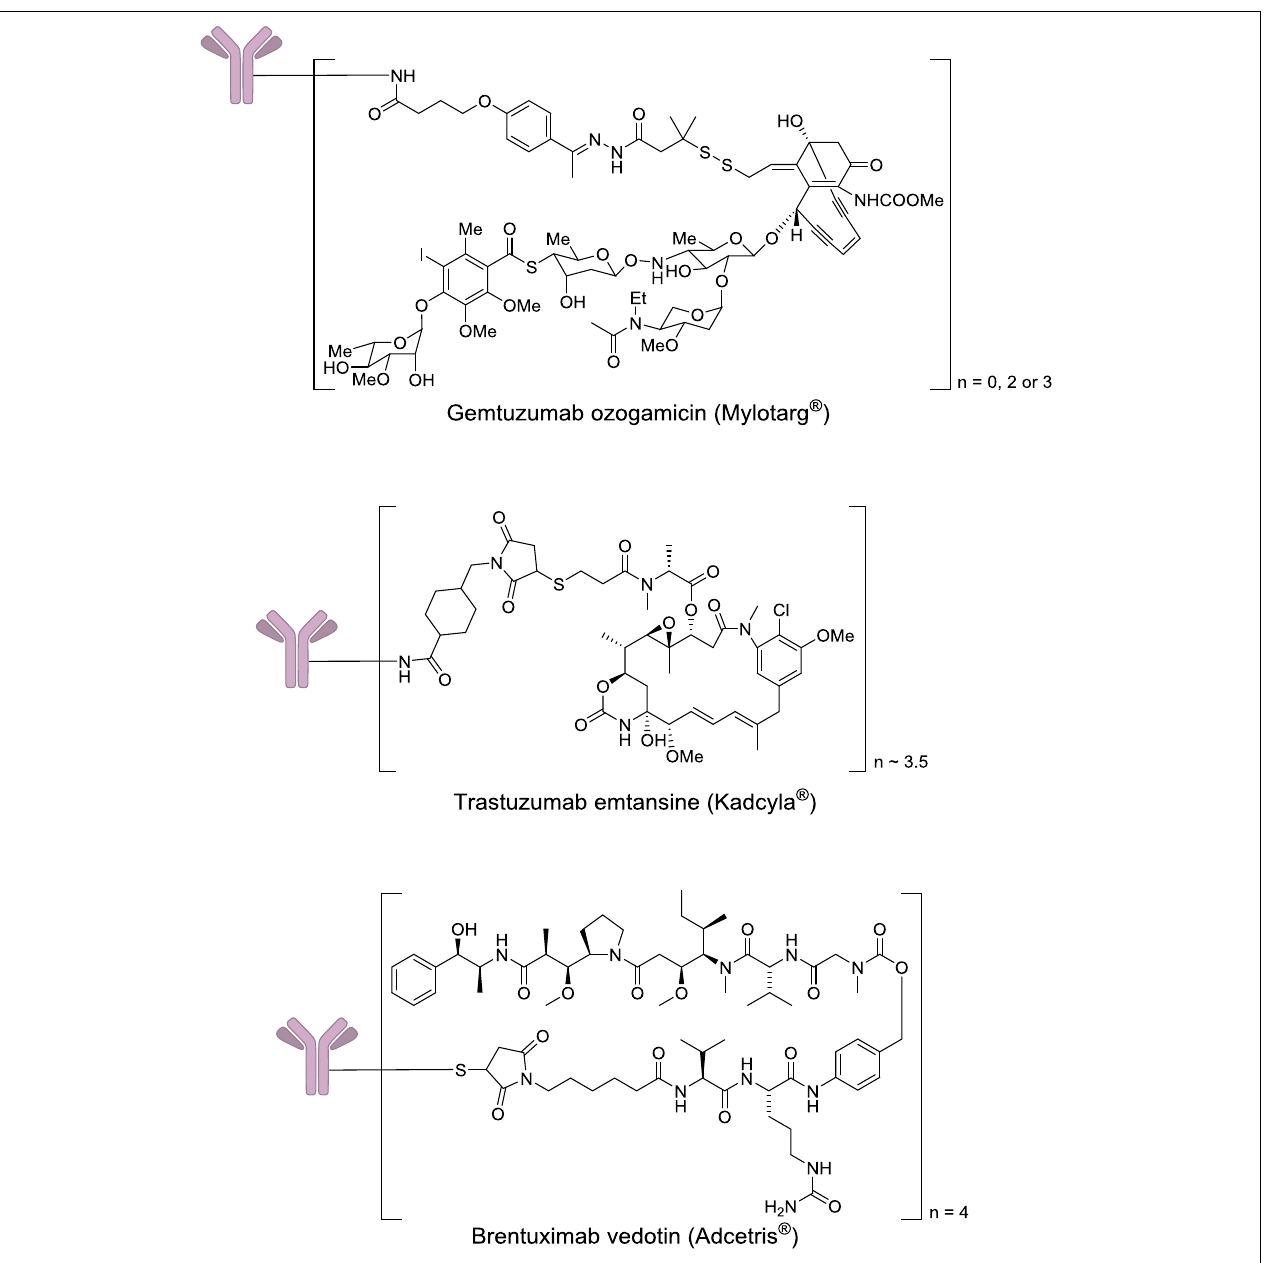
FIGURE 7 | Structures of marketed